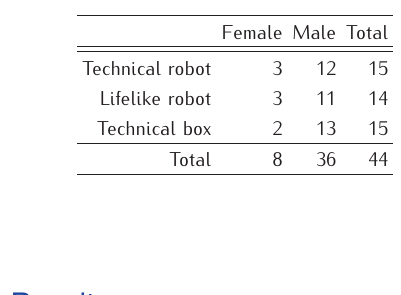
Table 1. Distribution of participants across the experimental conditions.